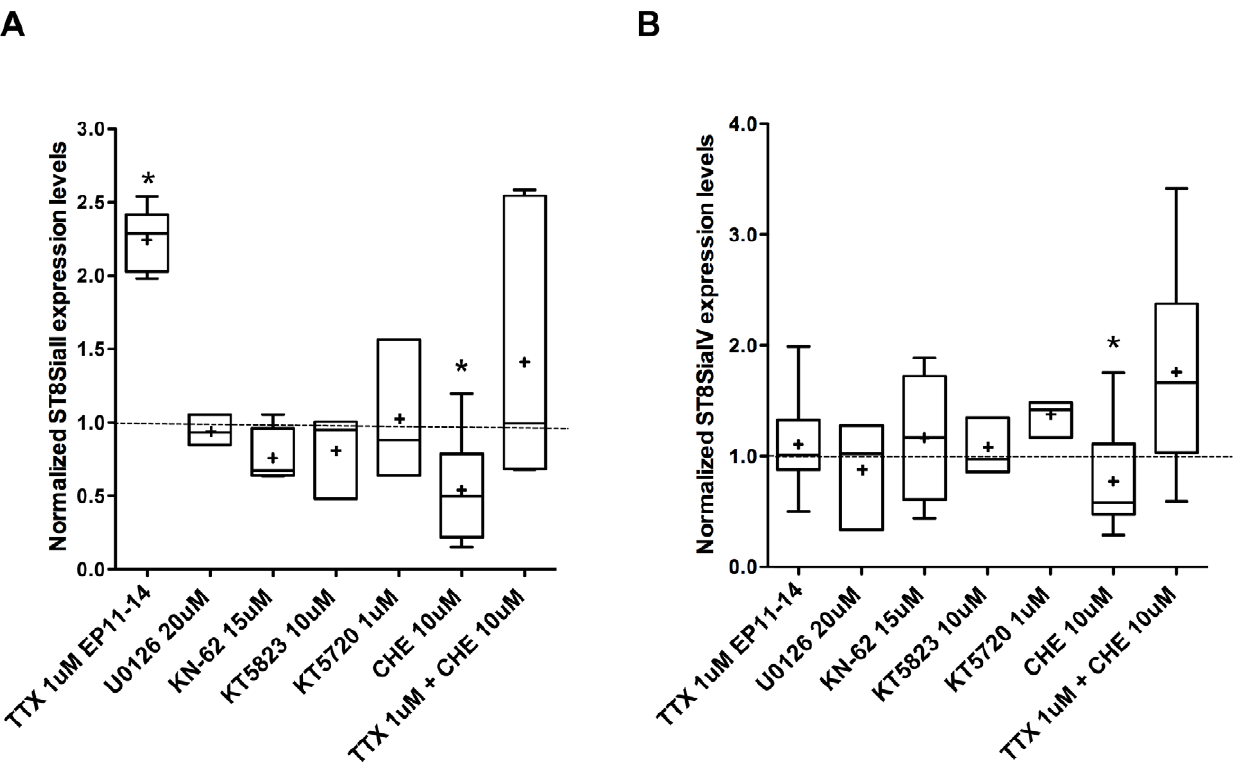
Figure 5. PKC signaling pathway positively regulates ST8SiaII and ST8SiaIV mRNA expression levels. Graphs illustrating the effect of the pharmacological inhibition of different signaling pathways on ST8SiaII (A) and ST8SiaIV (B) mRNA levels. Both ST8SiaII and ST8SiaIV mRNA levels are prematurely down-regulated in chelerythryne (CHE)-treated samples, compared to controls (Two-Way ANOVA, by post hoc Dunn’s test, *p , 0.05). TTX-induced increase in ST8SiaII mRNA levels (*p , 0.05) does not occur in presence of CHE. Indeed, ST8SiaII levels in CHE + TTX cultures are not significantly different from those found in controls (Two-Way ANOVA, by post hoc Dunn’s test, p . 0.05). Neither ST8SiaII (A) or ST8SiaIV (A) mRNA levels are affected by the application of U0126, KN-62, KT5823 and KT5720 (Two-Way ANOVA, by post hoc Dunn’s test, p . 0.05). Graphs are plotted as explained in Figure 2.